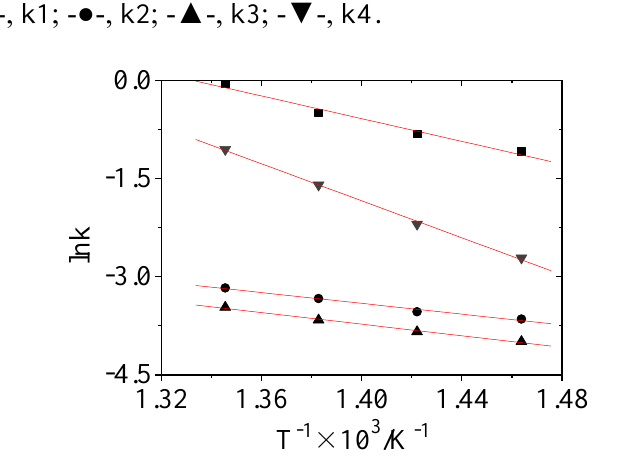
Figure 3. Arrhenius curve of the 4-lumped kinetic model for Shenhua CHLR